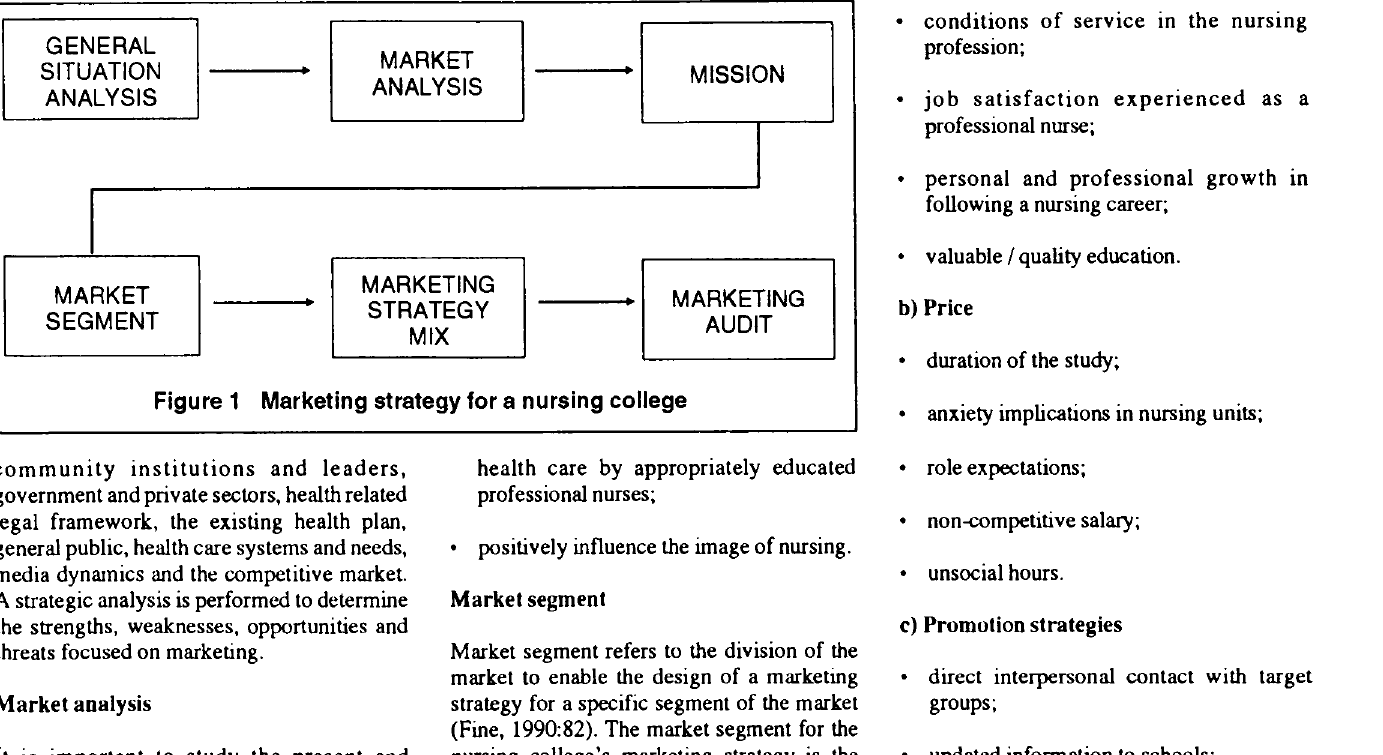
Figure 1 Marketing strategy for a nursing